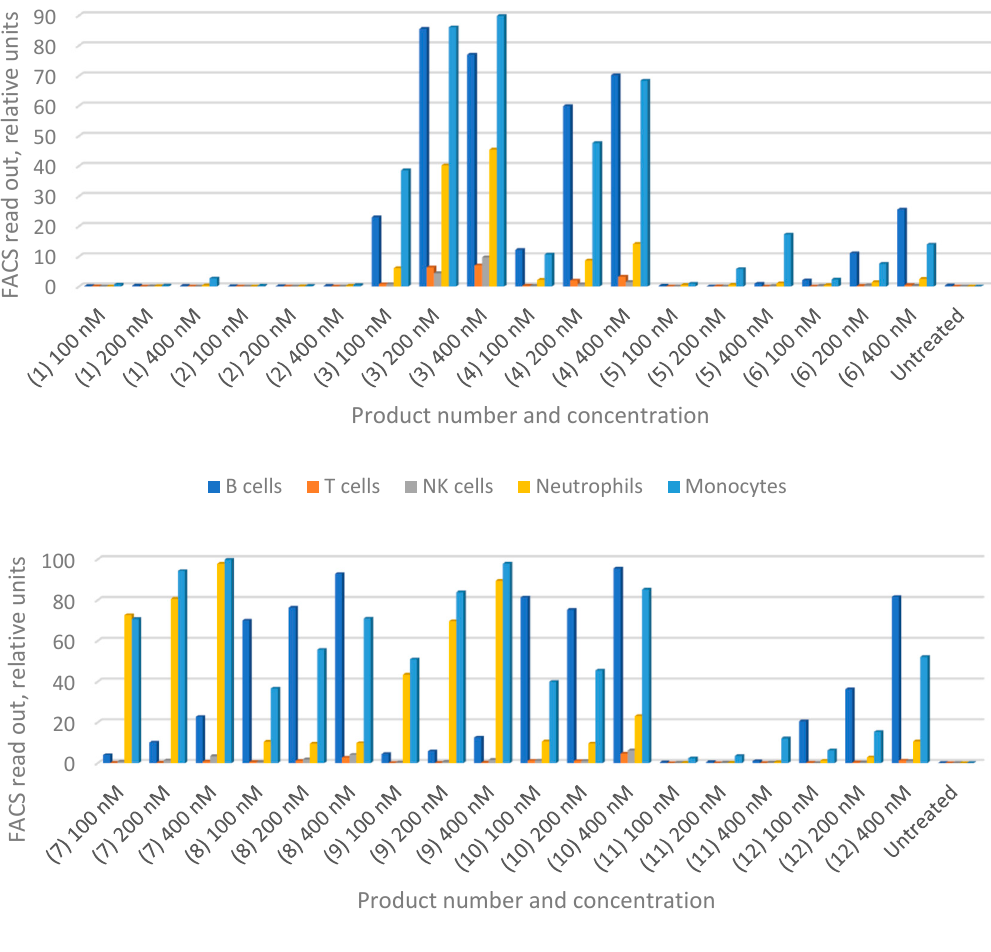
Figure 3. Flow cytometry analysis (FACS) data for nanotube products (C1–C12) incubated with human whole blood. See content of each product in Table 1. PEGylated indirect nanotubes HiPco-SWCNTs with and without MTX attached to siNOTCH (1 and 2) or scrambled siRNA (3 and 4); loaded with MTX (5); with no cargo in (6). PEGylated carboxyl-SWCNTs were with and without MTX attached to siNOTCH (7 and 8), or scrambled siRNA (9 and 10); loaded with MTX (11), with no cargo in (12).